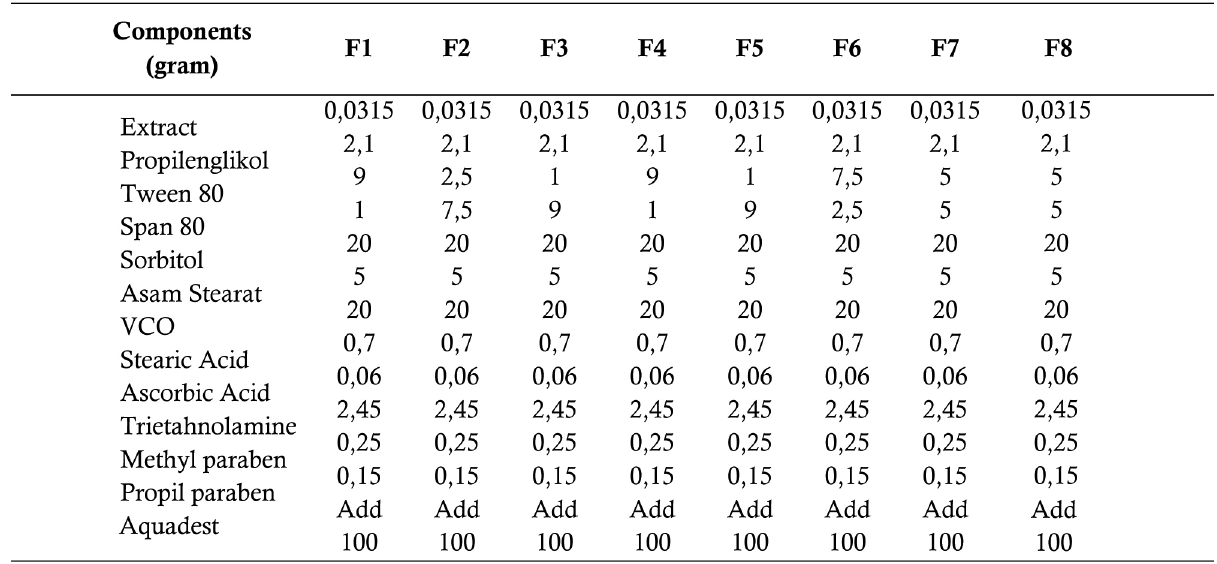
Eight Formulas of Corn silk extract antioxidant